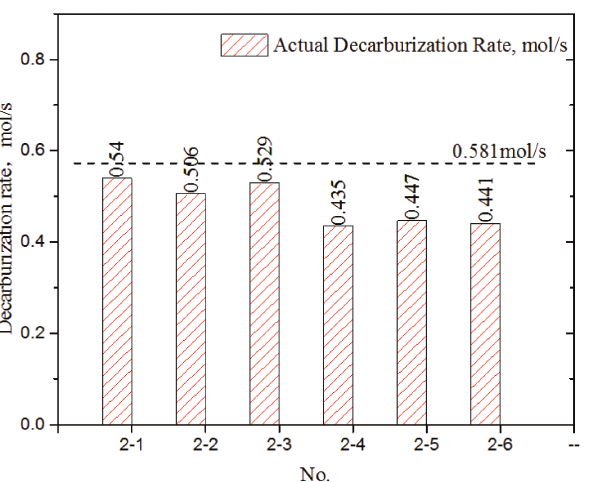
Fig. 9: Comparison picture of actual decarburization rate and calculated